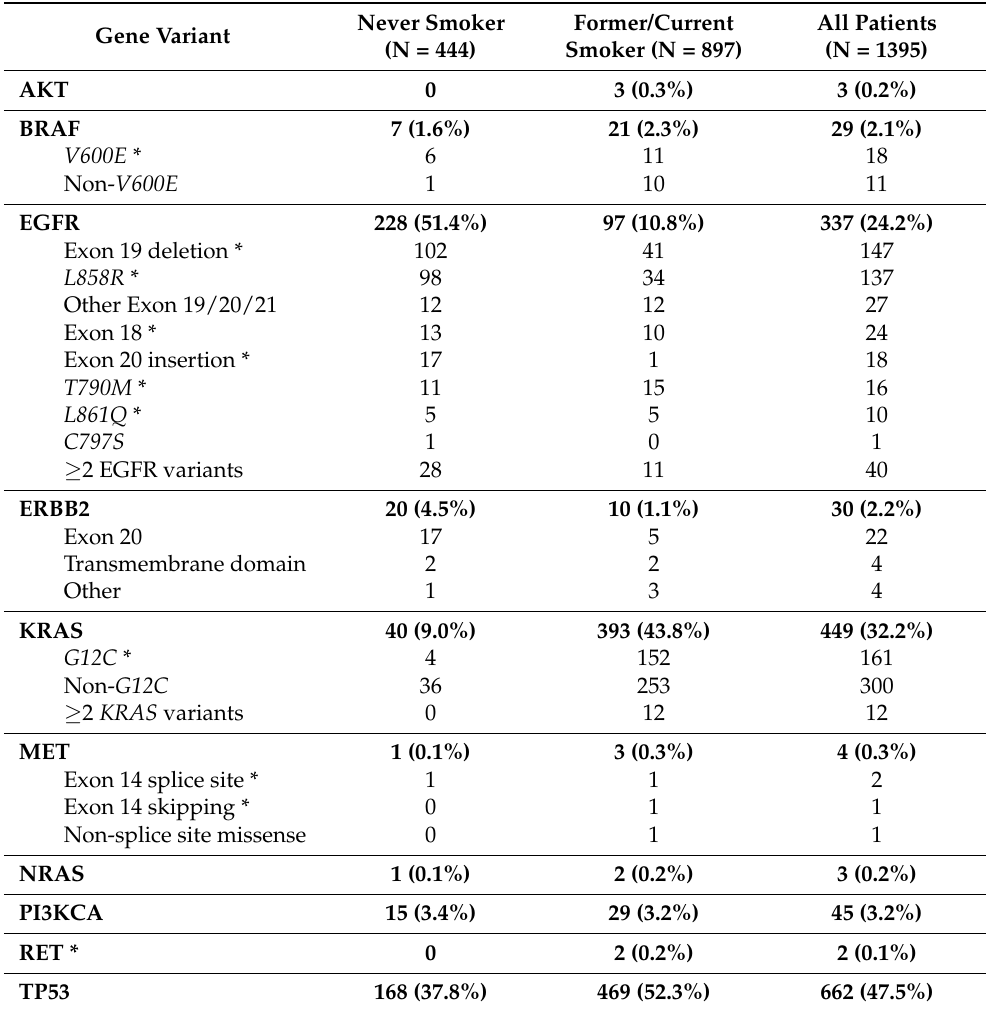
Table 3. Molecular results based on smoking status.